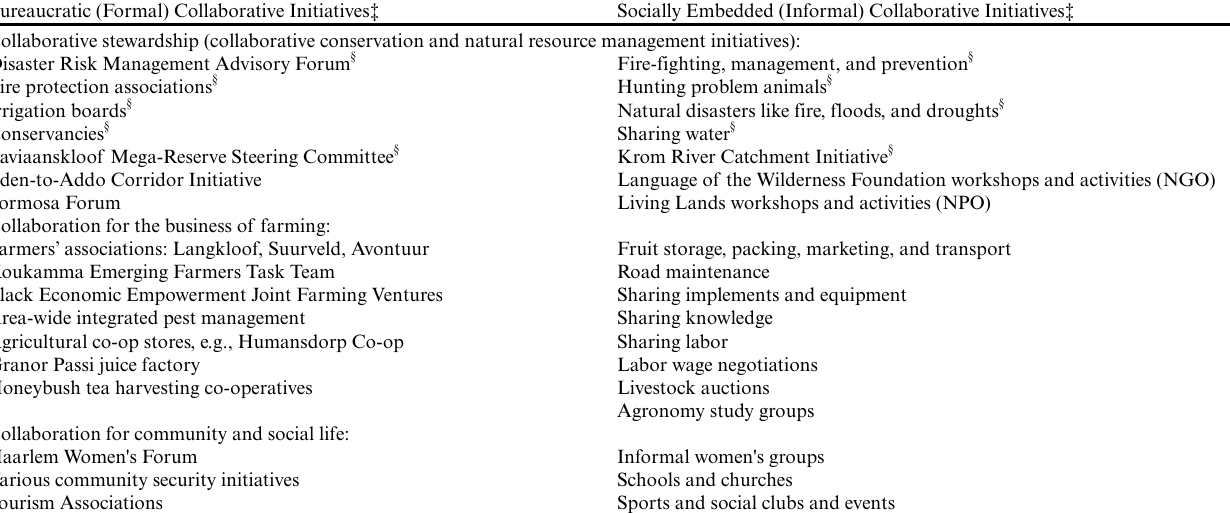
Table 2 . Existing and recently existing† collaborative initiatives in the Langkloof region. Note: this is not intended to be an exhaustive